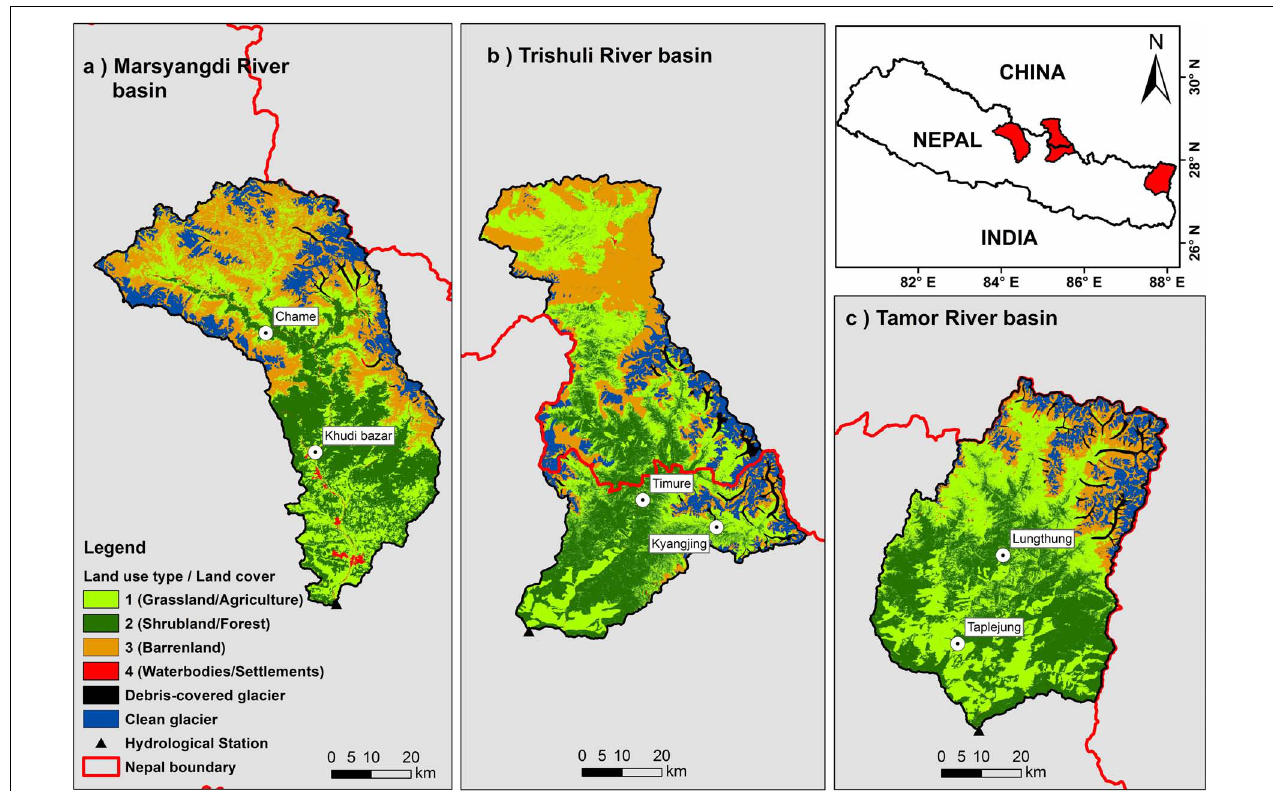
FIGURE 1 | Location map of (a) Marsyangdi, (b) Trishuli, and (c) Tamor River basins in Nepal (map of Nepal in the inset). The map showing land use types with clean and debris-covered